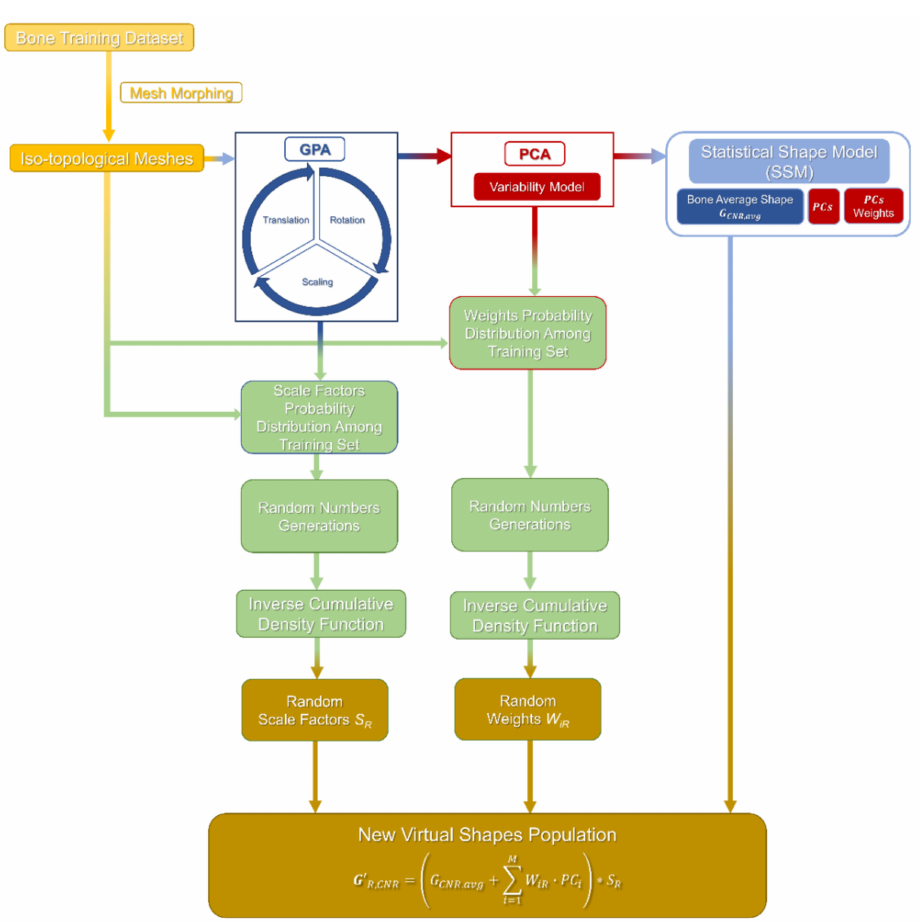
Figure 1. A schematic workflow gathering the steps of the whole procedure: mesh morphing, Generalized Procrustes Analysis (GPA), Principal Component Analysis (PCA), Statistical Shape Model (SSM) and stochastic